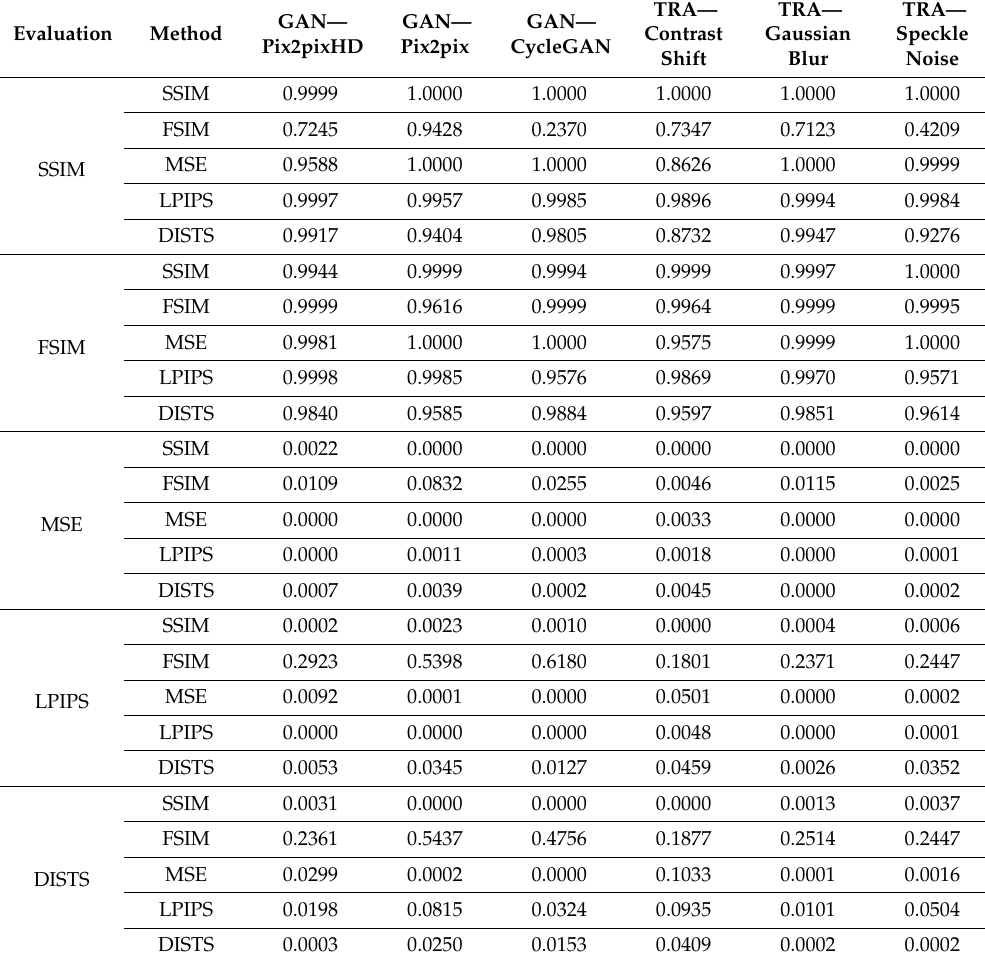
Table A2. Quantitative data for guiding the ranking of the evaluation metrics. Unlike SSIM and FSIM, smaller values mean better results in MSE, LPIPS and DISTS. GAN and TRA in the header mean GAN distortion and Traditional distortion,